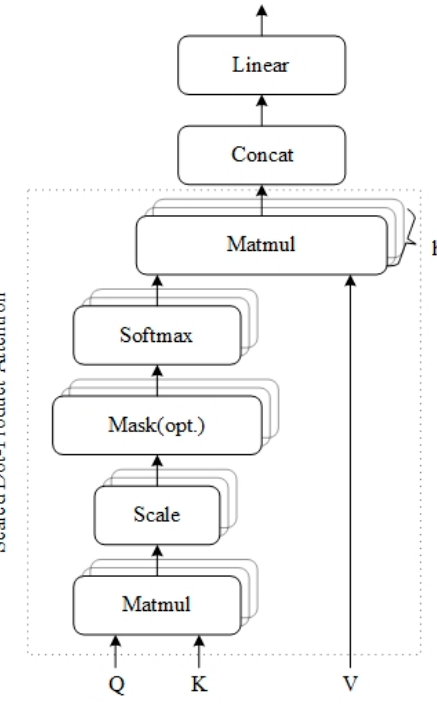
Figure 4. Multi-Head Self Attention structure.